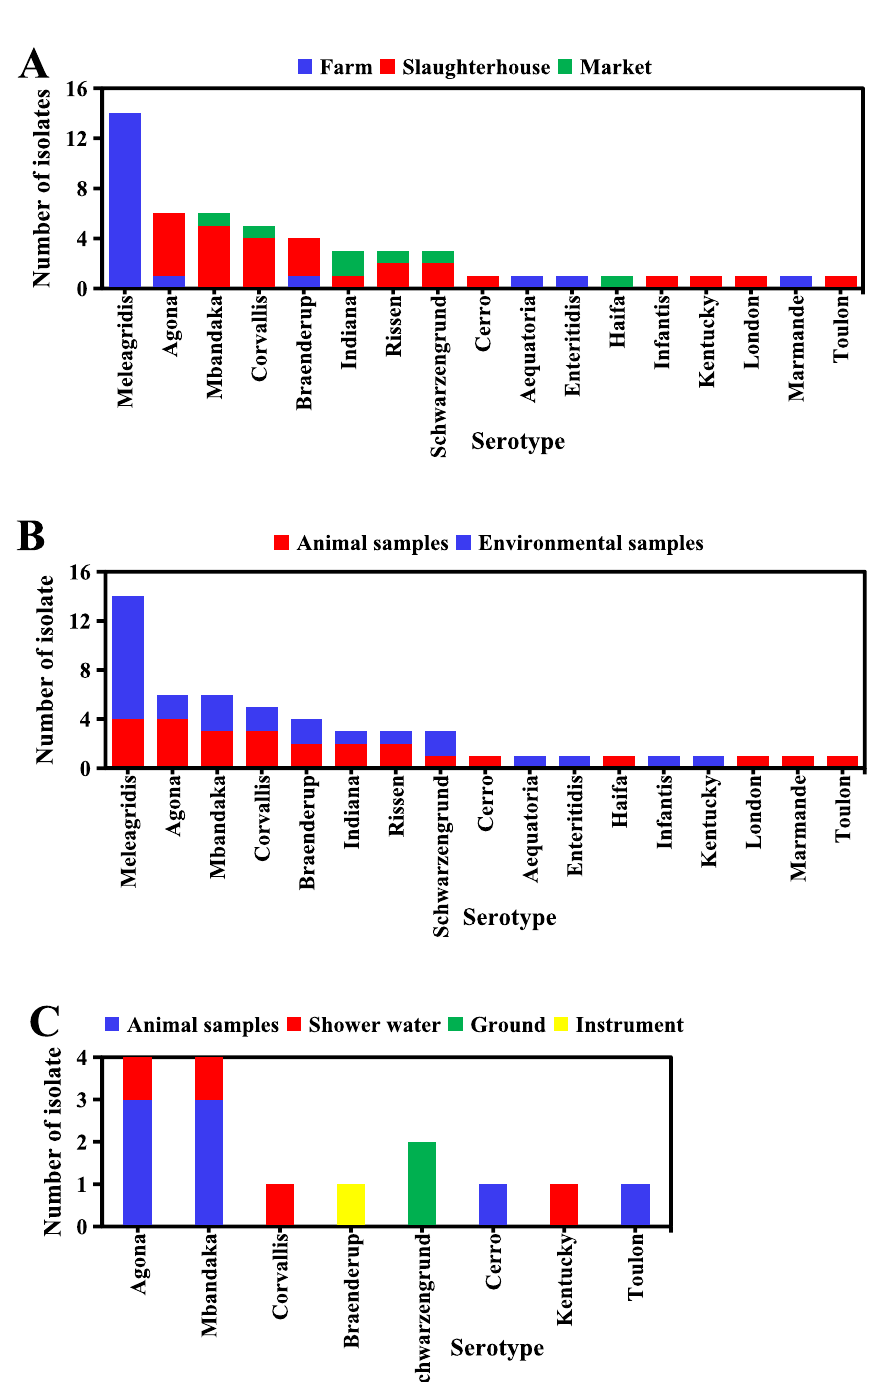
Fig. 1 Serotypes of 53 Salmonella isolated in the chicken production chain in Hubei Province, China. A Serotype distribution in different links. B Serotype distribution according to animal and environmental samples. C Serotype distribution in WYS